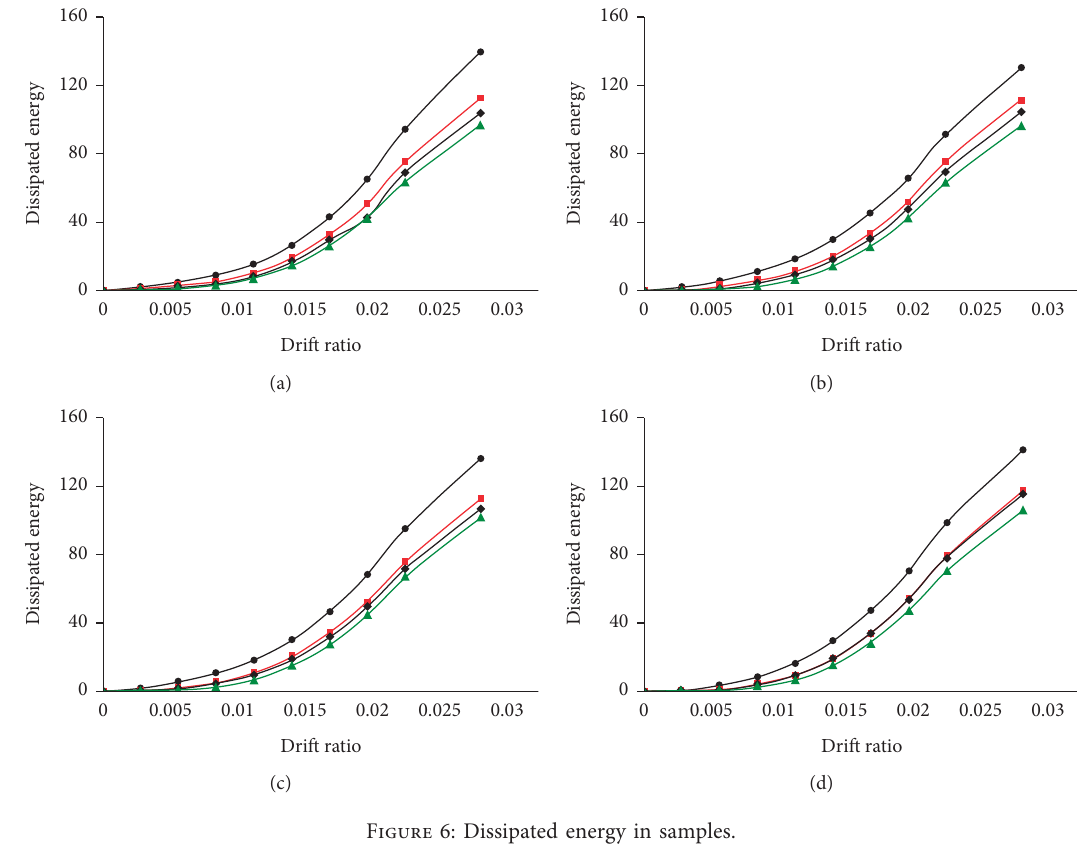
Figure 6: Dissipated energy in samples.